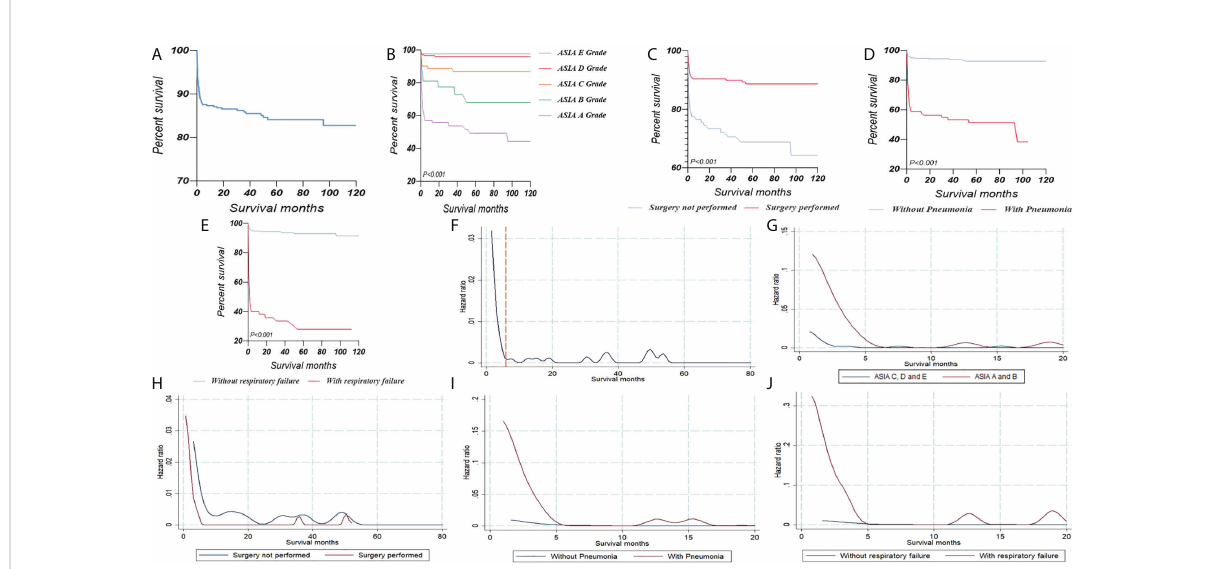
FIGURE 1 (A) Kaplan – Meier survival curves illustrating the overall survival of cervical fracture patients with AS. Kaplan – Meier survival curves strati fi ed by ASIA grade (B) , surgery (C) , pneumonia (D) and respiratory failure (E) . Hazard functions for death in cervical fracture patients with AS (F) . Hazard functions curve strati fi ed by ASIA grade (G) , surgery (H) , pneumonia (I) and respiratory failure (J) . AS, ankylosing spondylitis; ASIA, American Spinal Injury Association impairment